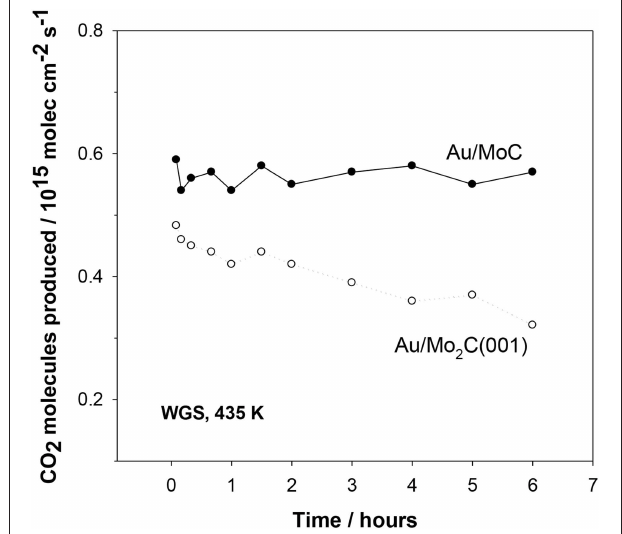
FIGURE 9 | Effect of time on the water-gas shift activity of Au/ δ -MoC and Au/ β -Mo 2 C(001) surfaces. Initially, 0.15ML of Au were deposited on the carbide substrates and the obtained catalysts were exposed to 20 Torr of CO and 10 Torr of H 2 O at 435K. For the Au/ δ -MoC system, the coverage of oxygen found after reaction with XPS remained constant ( ∼ 0.25ML). Such was not the case for the Au/Mo 2 C(001) system, where a substantial coverage of oxygen was always present ( > 0.5ML) and rised with time causing the deactivation of the system. Reproduced with permission from Posada-Perez et al. (2017) , copyright 2017 by Royal Society of